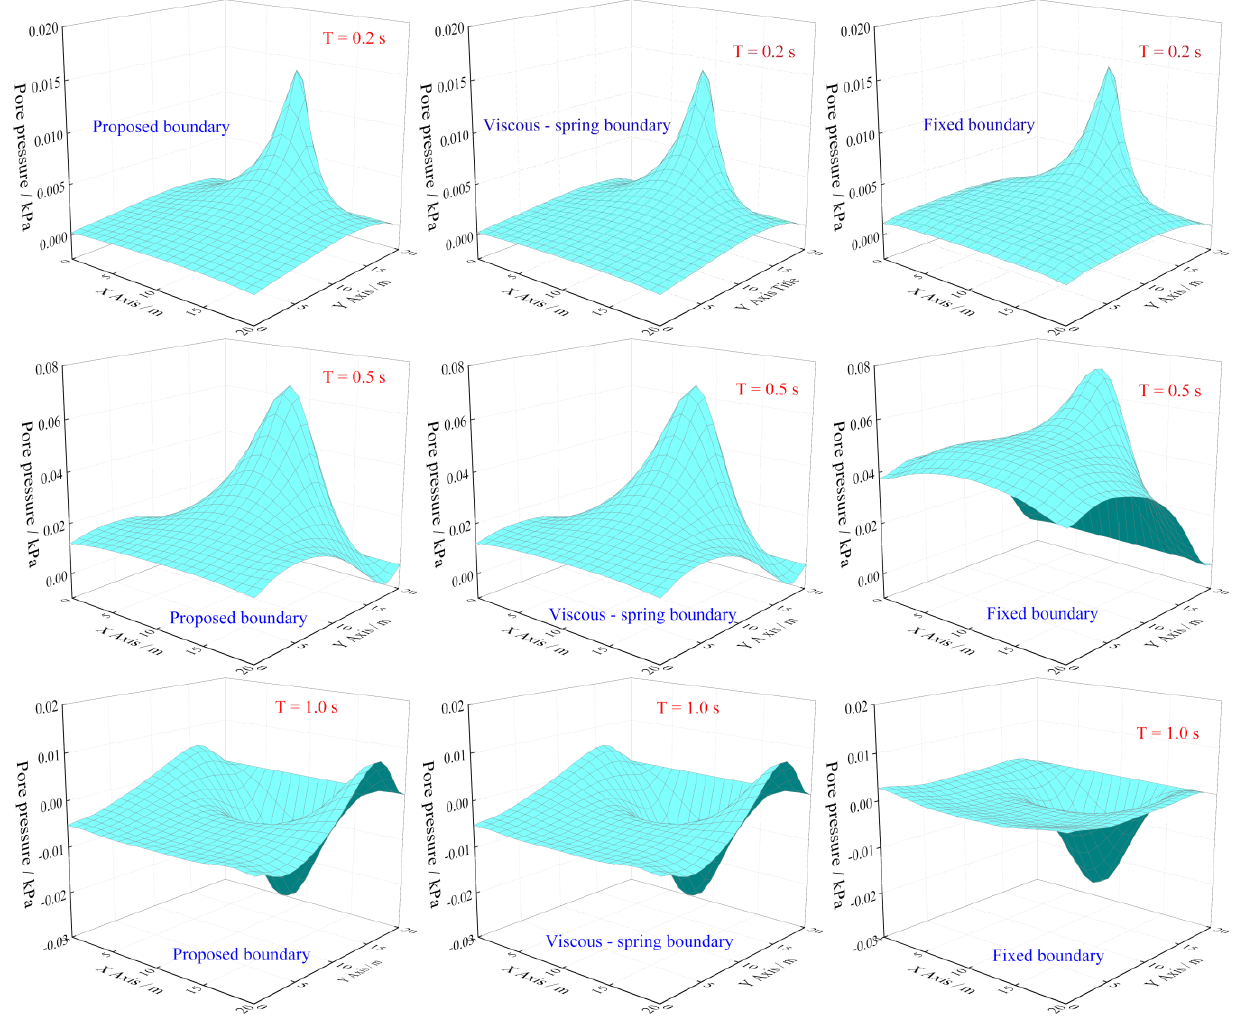
Figure 9. Comparison of pore pressure at different time.